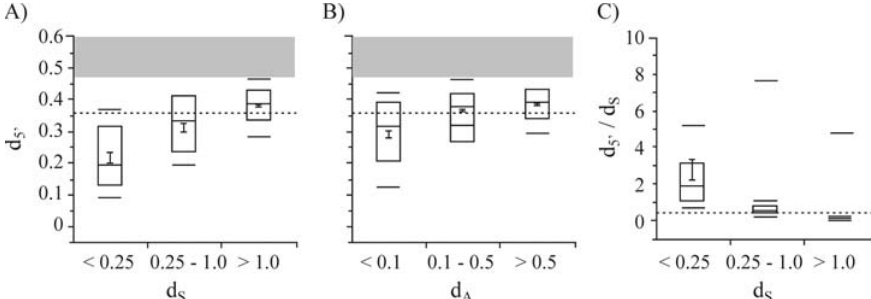
Figure2 -Theaveragegeneticdistancewithinalignedsequenceblocks(d 5’ )inrelationtosynonymous(A)andamino-acidsite(B)divergence(d S andd A , respectively),andtheevolutionaryrated 5’ /d S .Thefollowingquantilesareshown:90%,75%,mean(1SE),median,25%,and10%.Themeansofthebins shown differ at α = 0.001 (A) and α = 0.05 (B) (Student’s t-test). No further significant differences were found between any of the original bins given in the methods section. The grand mean is depicted by the dotted line. The shaded area represents the 99% range of values obtained from alignments of ran- domly paired single copy D. melanogaster genes (set of single-copy